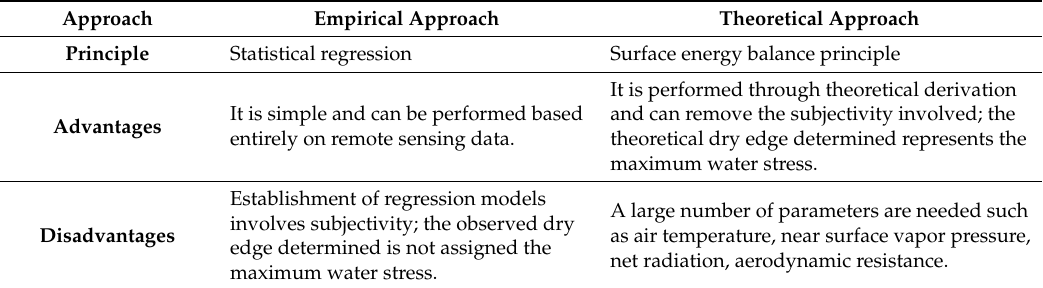
Table 1. Contrast of empirical and theoretical approaches for the determination of dry